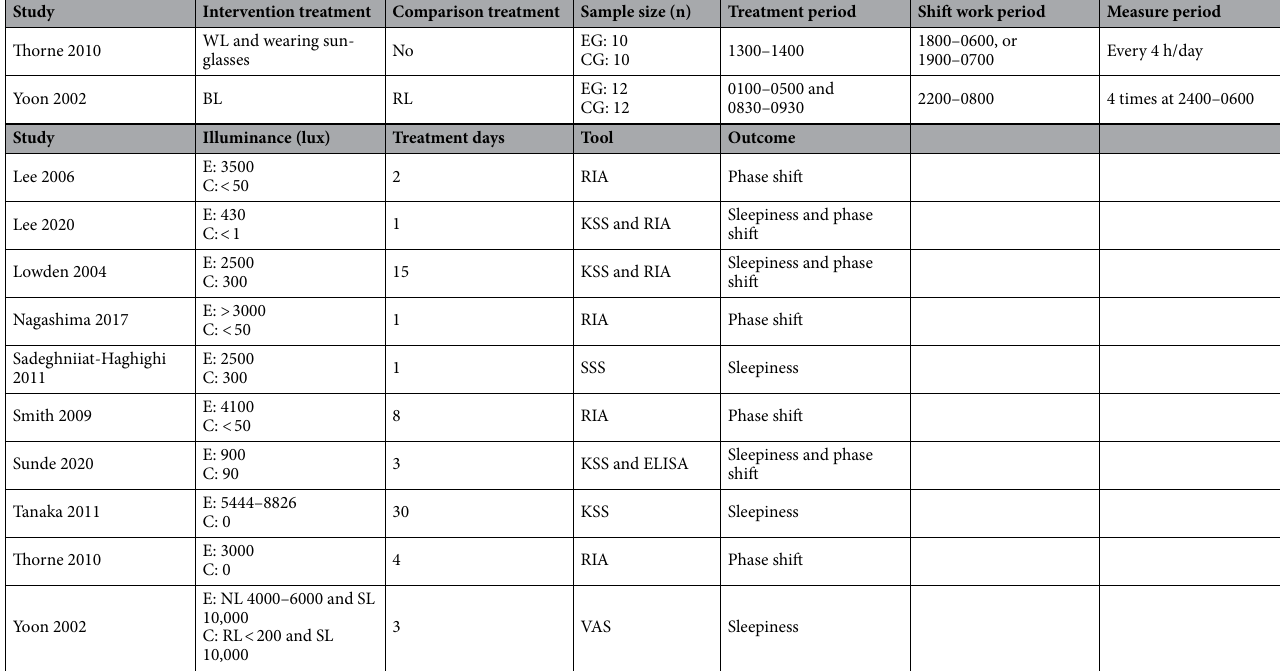
Table 2. Intervention characteristics of the included studies. BL bright light, DL dim light, WL white light, NL nocturnal light, SL sunlight, RL room light, E experimental group, C control group, No no